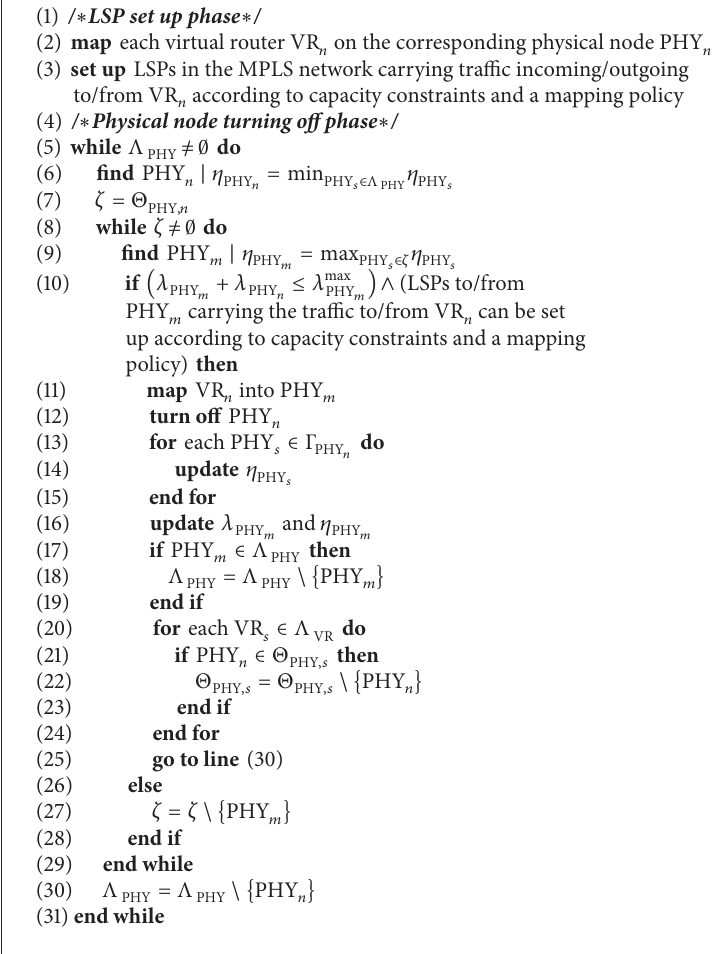
Algorithm 1: Maximum energy